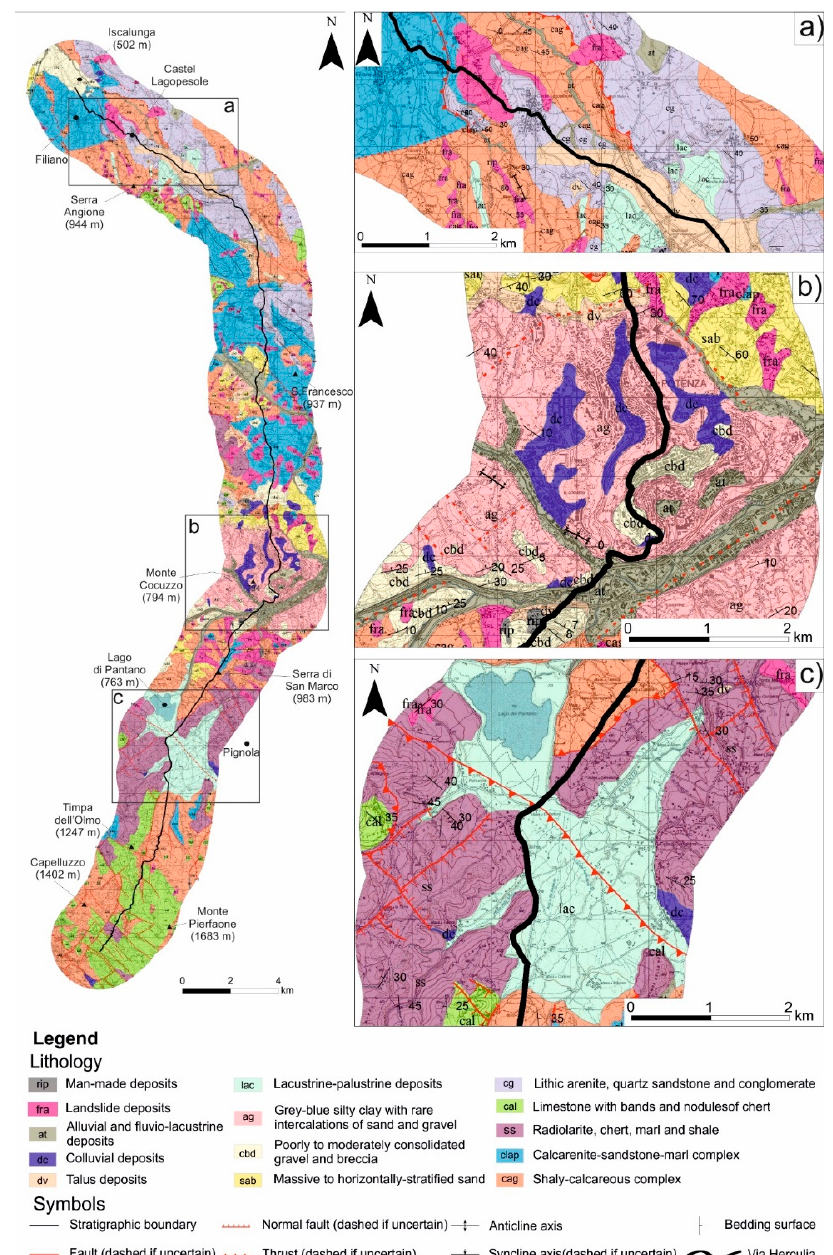
Figure 4. Geolithological maps of the sample test-site and detailed sketches of several segments of the Herculia roman road ( a , b , c ).